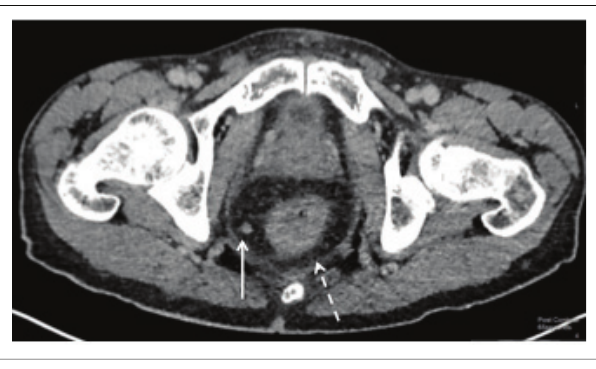
CT, Computed tomography. FIGURE 9: Axial reconstruction, portovenous-enhanced CT imaging of a 50-year- old male patient. The image demonstrates rectal thickening (dashed arrow) and an enhancing mesorectal node (solid arrow).